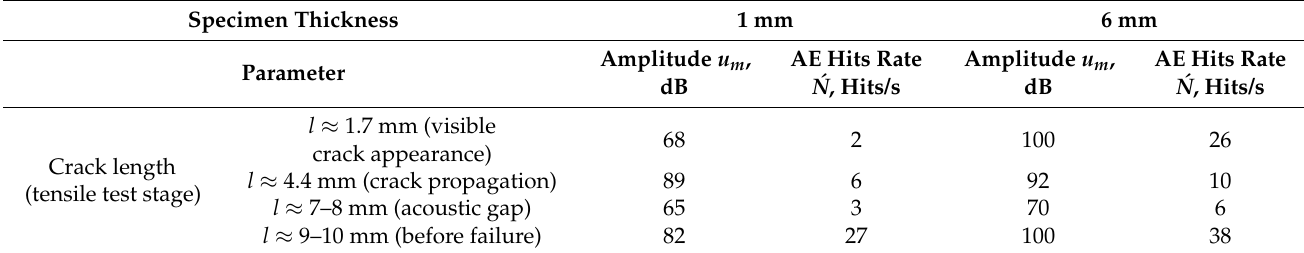
Table 3. Comparison of the amplitudes and AE hits rate at different stages of tension tests of specimens from 30 KhGSA steel with a thickness of 1 mm and 6